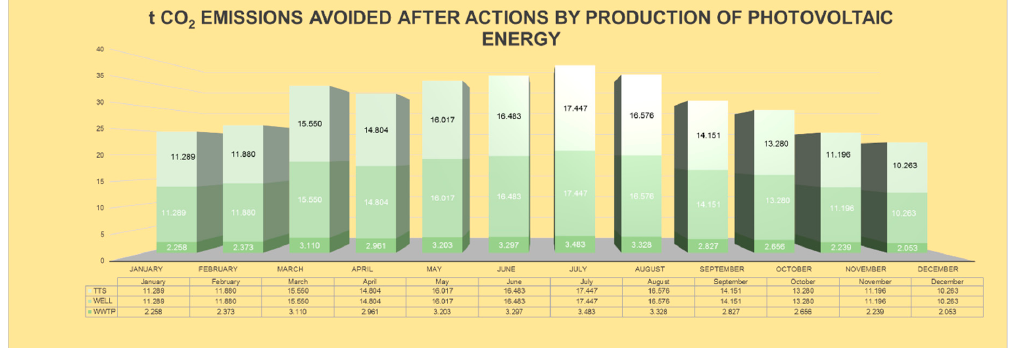
Figure 12. CO 2 emission in tons avoided by the production of photovoltaic energy.